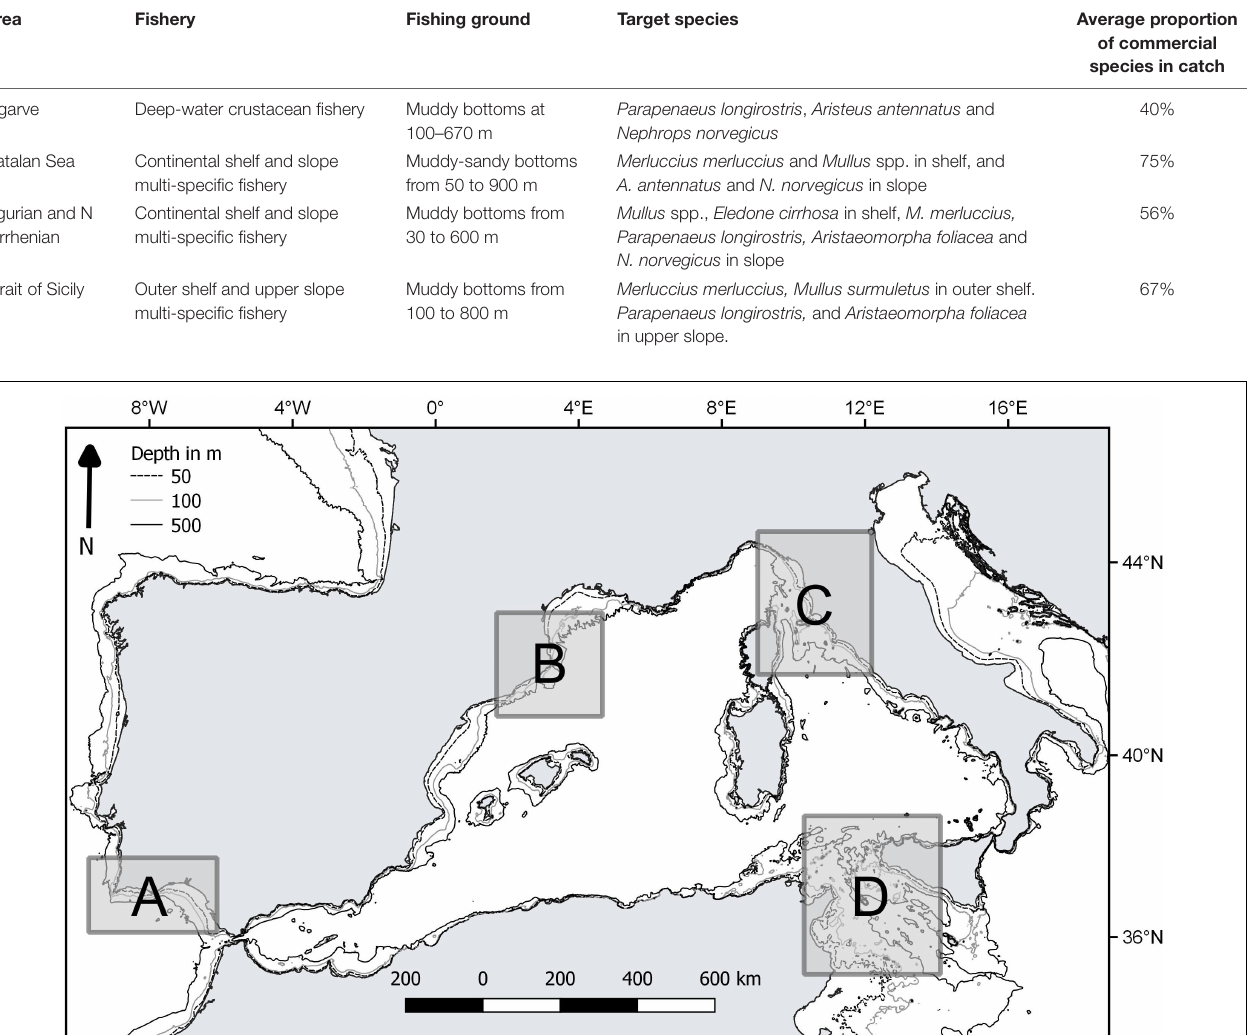
TABLE 2 | Characteristics of the trawl fisheries in the four case studies.